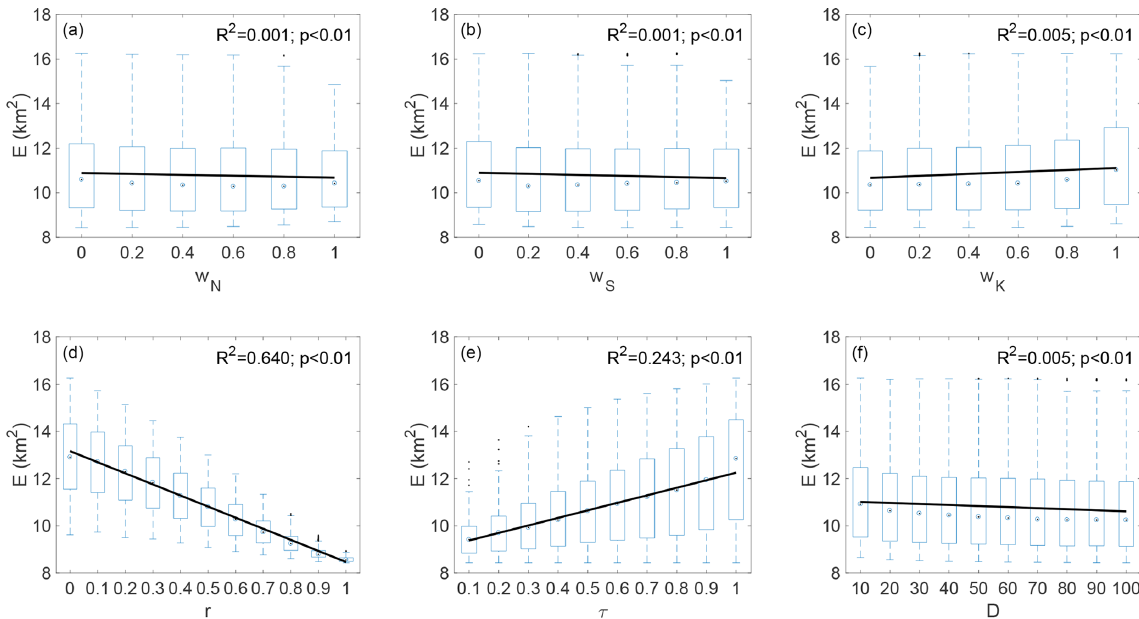
Figure 3. Relationships between the six Demeter parameters and the global average discrepancies between the downscaled and observed land cover areas ( E values) resulted from the Monte Carlo ensemble experiment. Box plots shows the distributions of the E values, and the solid lines show the linear trends.